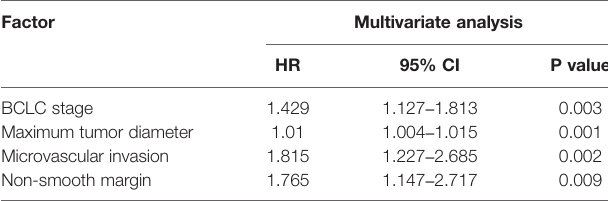
TABLE 3 | Factors associated with recurrence-free survival after curative resection according to multivariate analysis in the training cohort.